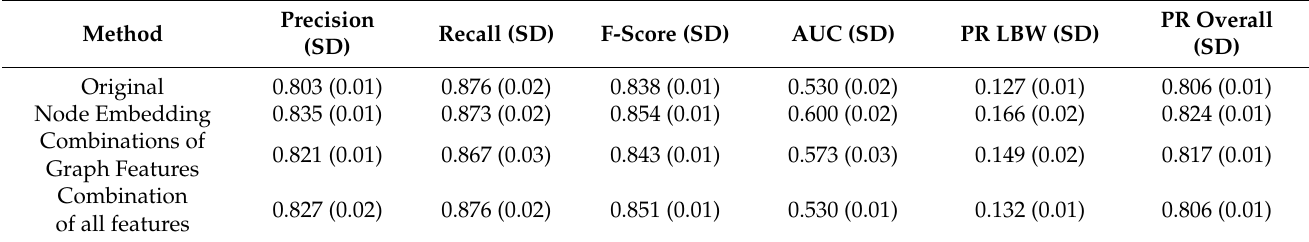
Table 6. Experiments performed using a KNN classifier.